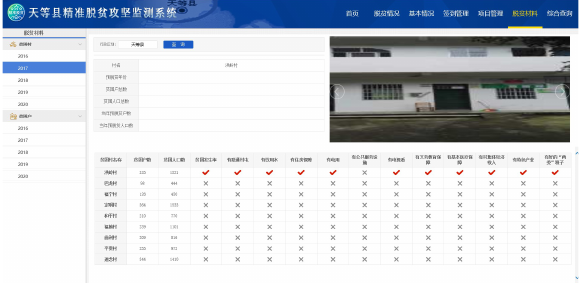
Figure 3. Monitoring Browser system screenshot